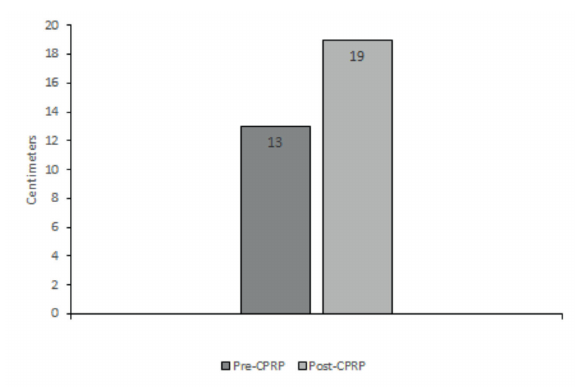
Figure 3 - Comparison of flexibility (cm) pre and post CPRP.